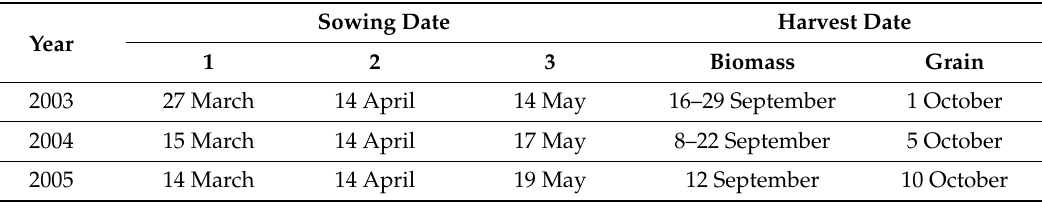
Table 3. Dates of sowing and harvesting for maize. The sowing rate was 85,000 plants ha − 1 with a distance of 71 cm between rows. The plot size of each experimental plot was of 15 × 11